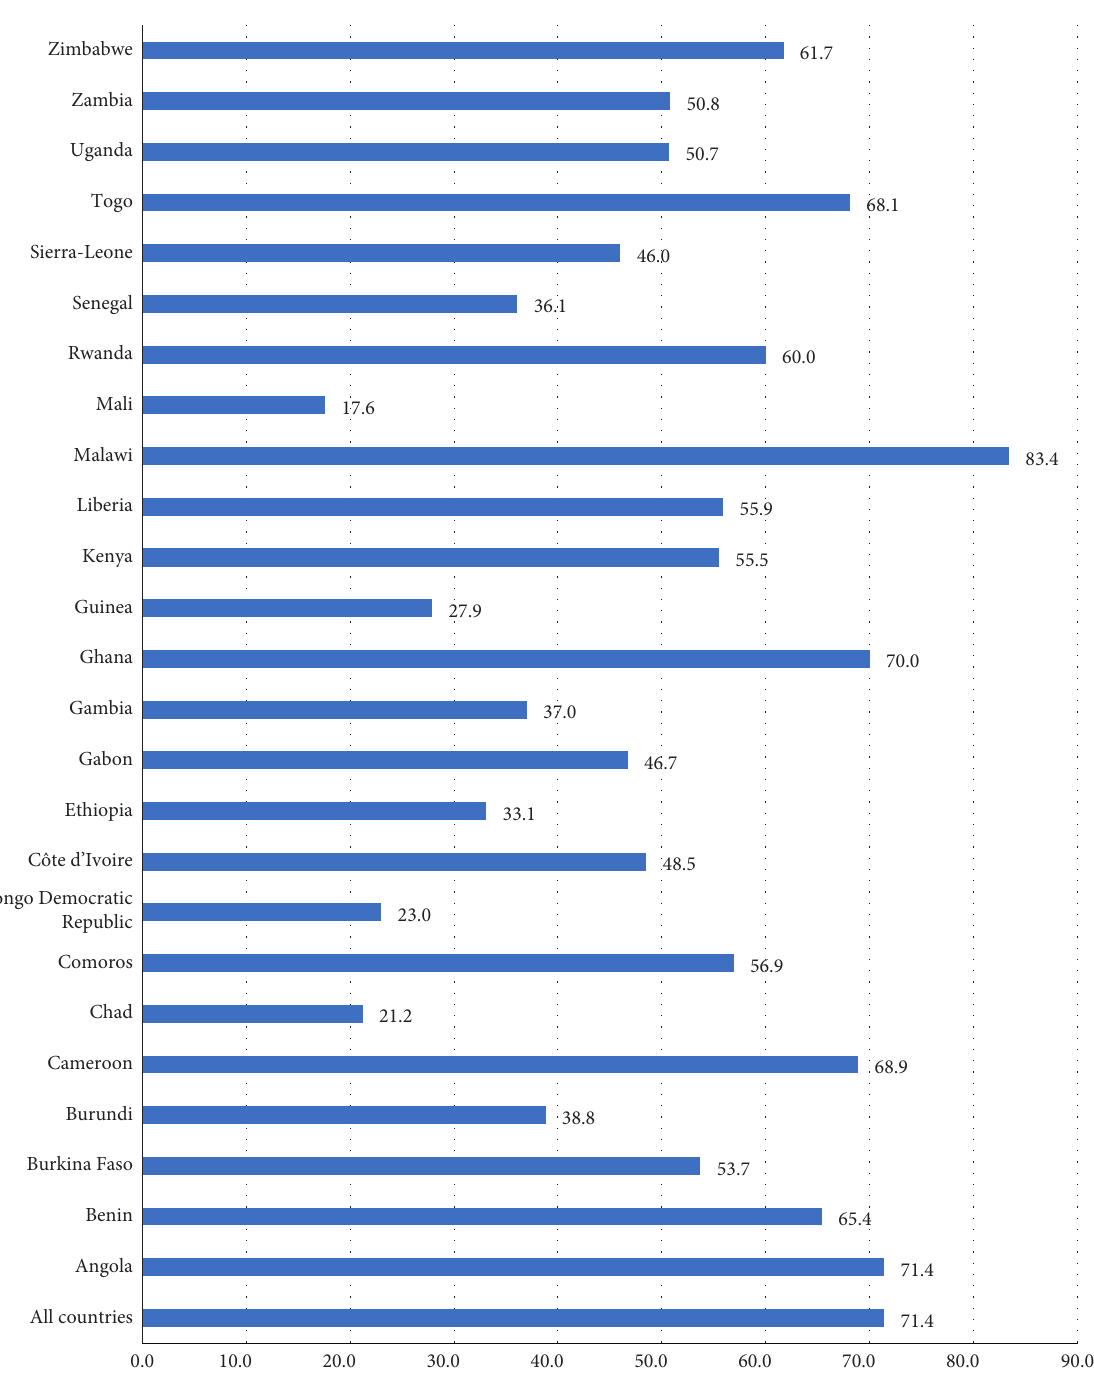
Figure 2: Prevalence of disagreement with wife beating among married women of children under five in